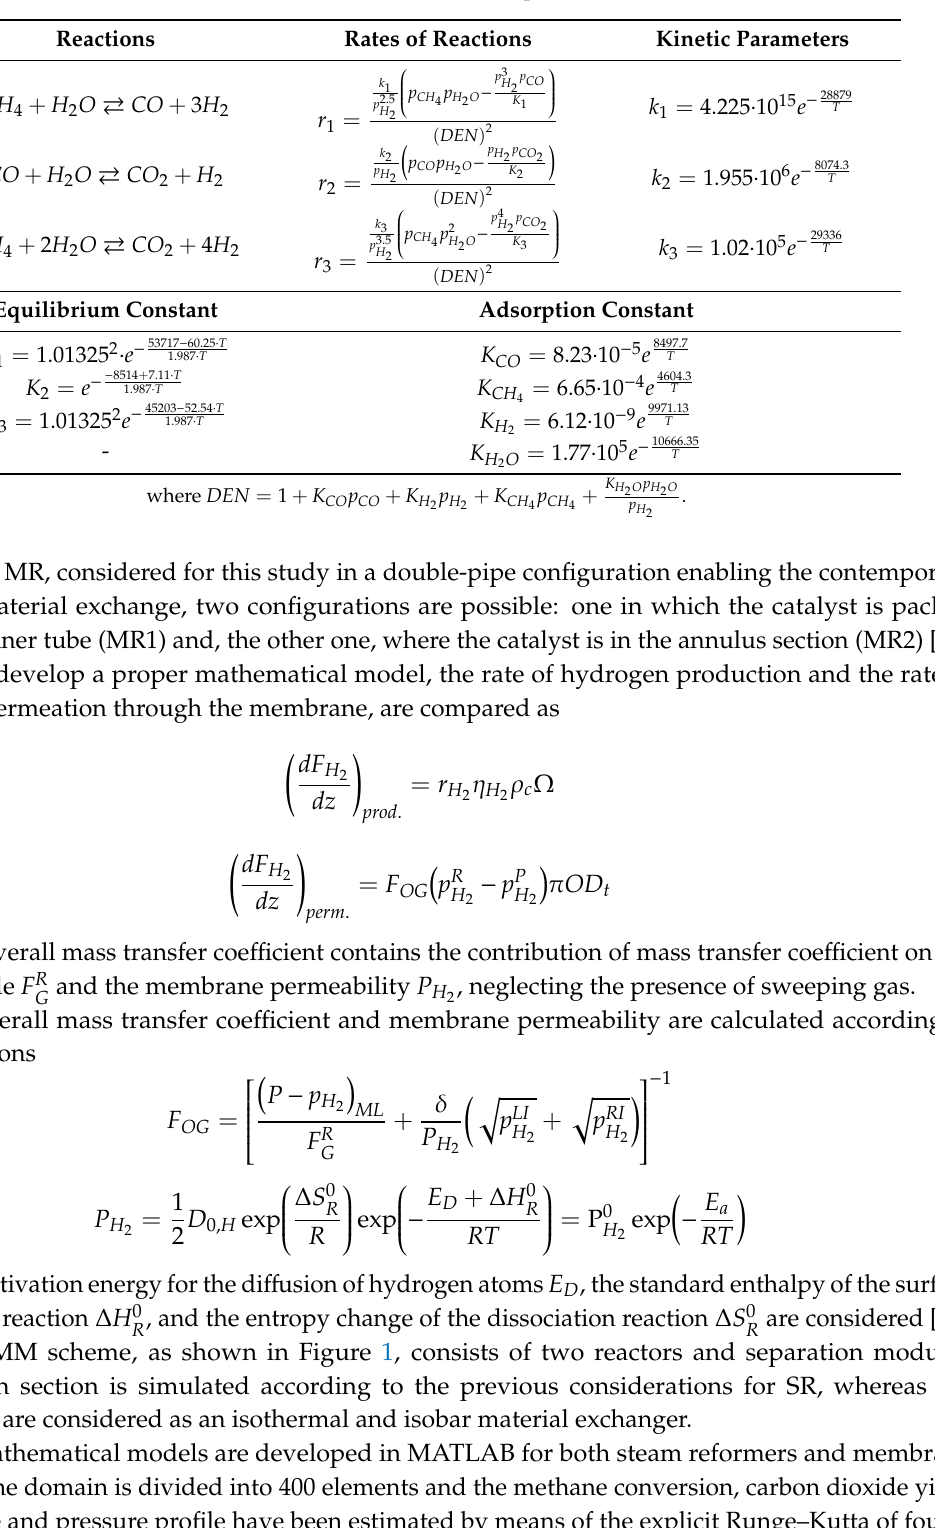
Table 1. Xu and Froment kinetic